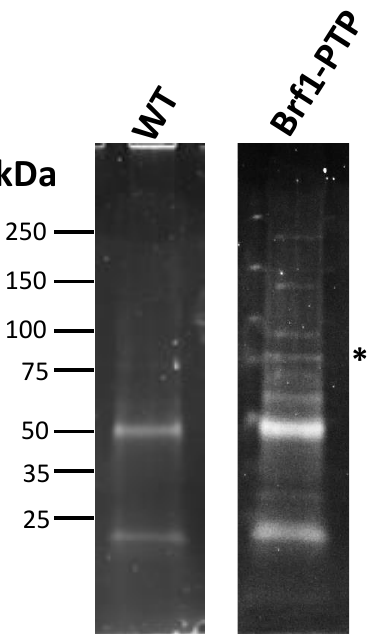
Figure 6. Tandem affinity purification with L. major cells expressing LmBrf1-PTP. SDS-PAGE of proteins co-purified with LmBrf1-PTP. The asterisk denotes the recombinant protein. A control experiment with wild-type cells (WT) is also shown. The samples were analyzed in 4–15% Mini- PROTEAN Precast Protein Gels stained with SYPRO Ruby.